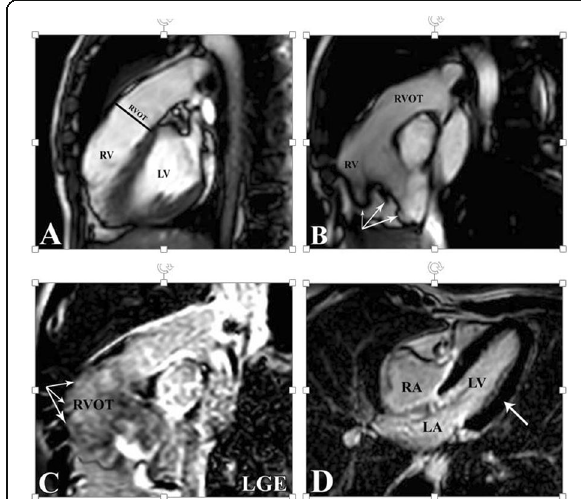
Fig. 6 Nine-year old female presented with recurrent attack of arrhythmia. RVOT view ( a ) show dilated RVOT with upper limit size of right ventricle and systolic dysfunction (reduced EF = 30%). RVOT view ( b ) shows RV wall thinning showing regional hypokinesia and dyskinesia (arrows). LGE imaging in RVOT ( c ) and 4-chamber ( d ) views showing focal strong enhancement is found in RV free wall (arrows in c ). The areas of enhancement correspond to the dysfunctional areas on cine imaging (Arrows in b ). Normal size and function and signal intensity of myocardium in LV. MRI finding cope with major MRI criteria of ARVD